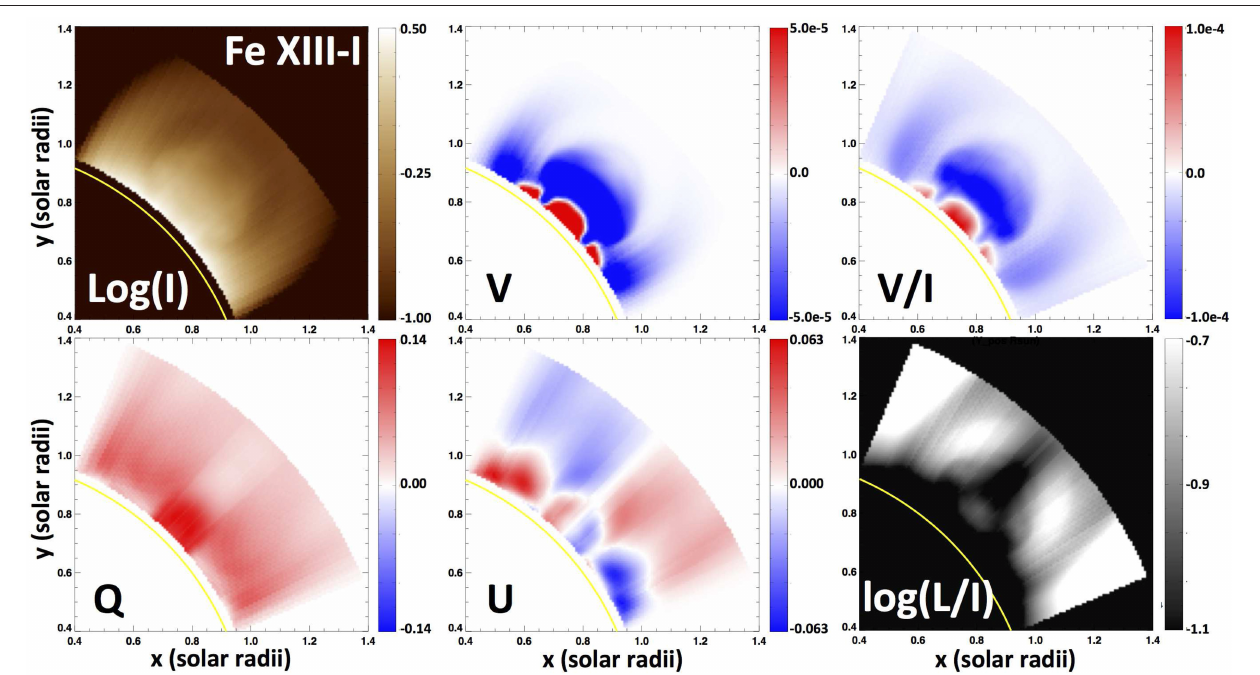
FIGURE 3 | Coronal synthetic images of the polarization signal for the ground truth. All four Stokes parameters ( I , Q , U , V ) are displayed together with the percentage of circular ( V / I ) and linear ( L / I = ( Q 2 + U 2 ) / I ) polarization. The yellow solid line shows the solar limb. p